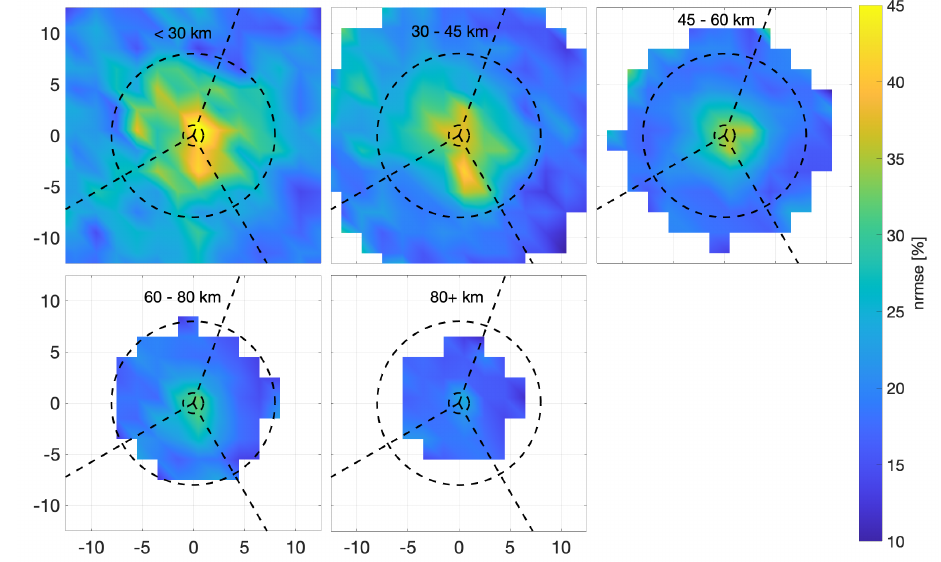
Figure 18. As in Figure 14, each subplot parsed by radius of maximum